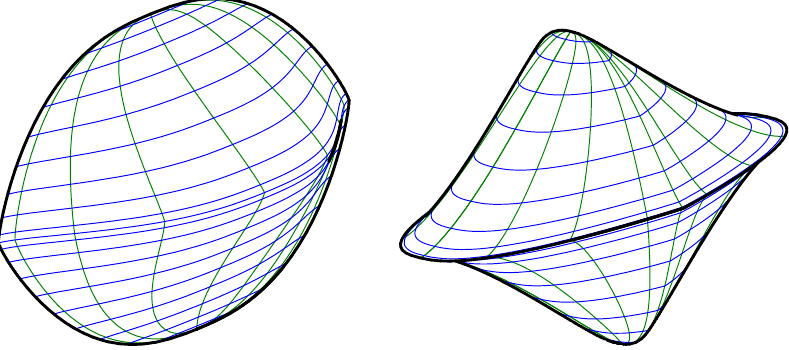
Figure 12. The same matrix A , but the exponents are